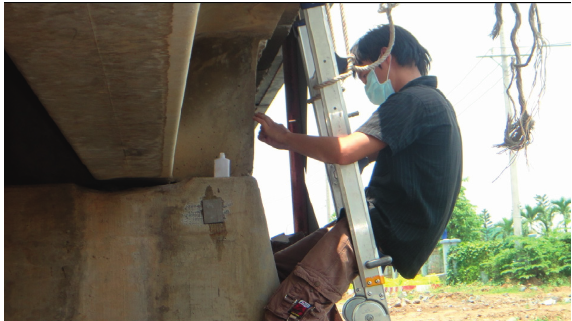
Figure 12: Measuring vibrating signals at Ben Noc